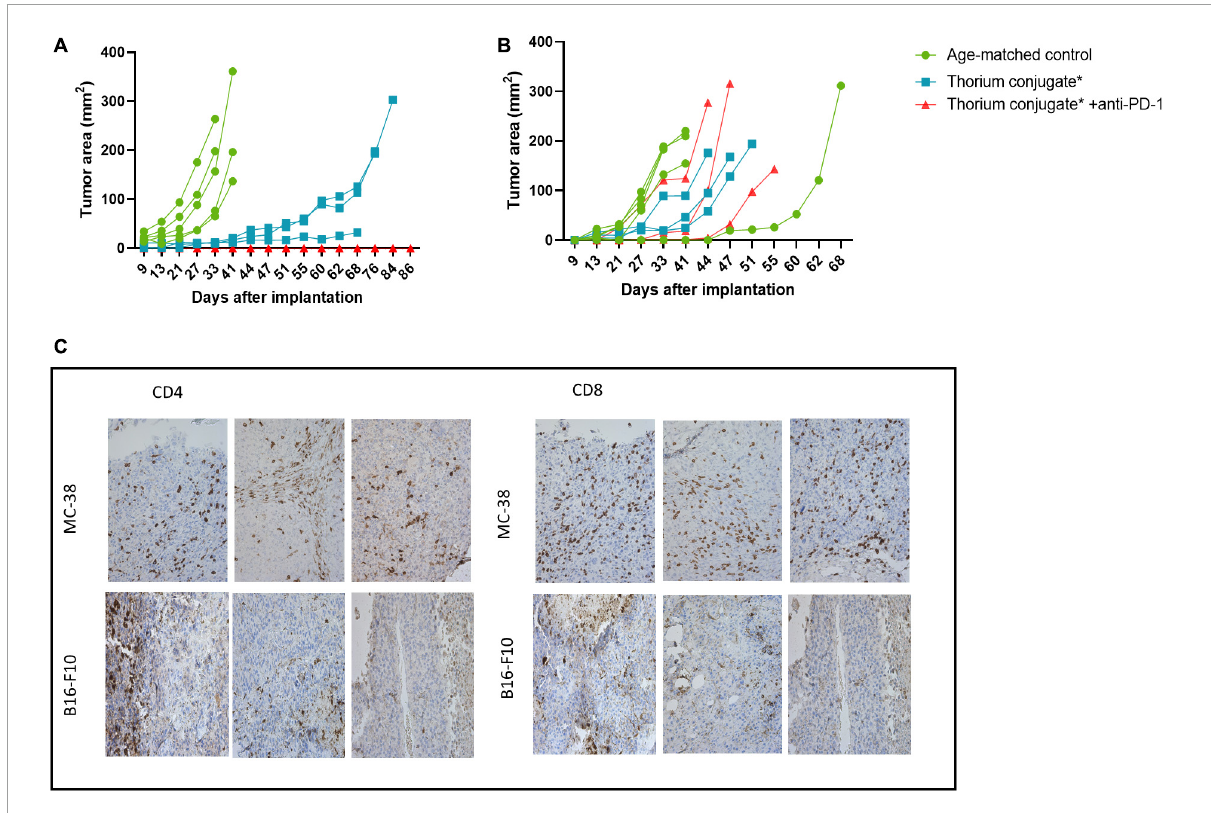
FIGURE5 (A) Growth curve for rechallenge with MC-38 cells after treatment as indicated, n = 5 in control groups, three in treatment groups. (B) Growth curve for rechallenge with B16-F10 cells after treatment as indicated, n = 5 in control groups, three in treatment groups. (C) IHC slides from MC-38 and B16-F10 tumors stained for CD4+ and CD8+ T-cells. Slides are from regrowing tumors of monotherapy treated mice. *Animals previously treated with either PD-L1 TTC or isotype Th-227